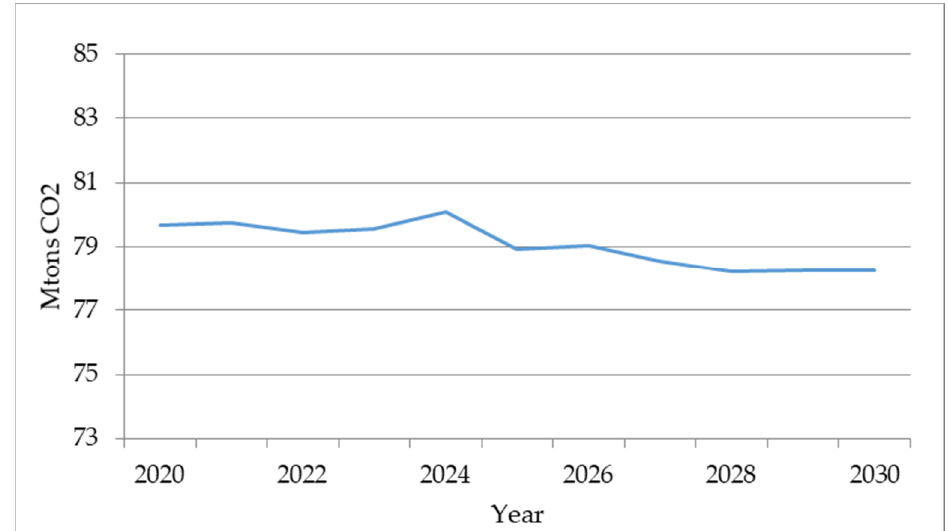
Energies 2021 , 14 , x FOR PEER REVIEW Figure 21. Total CO 2 emissions in the RENES scenario. Source: own elaboration with the model.